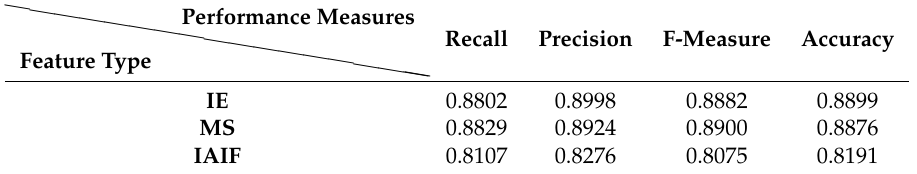
Table 7. Performance measures when using different features of Hilbert-Huang transform